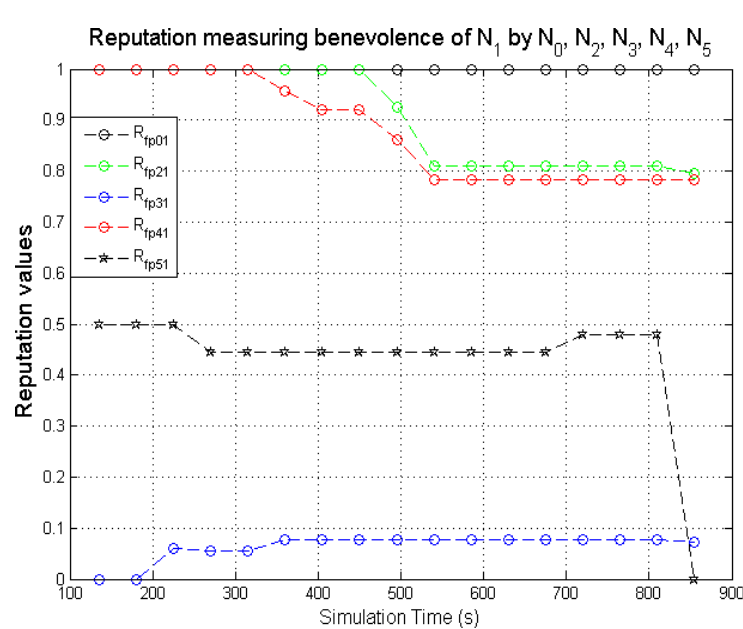
Figure 11. The reputation values ( R fp ) for N 1 computed by N 0 , N 2 , N 3 , N 4 , & N 5